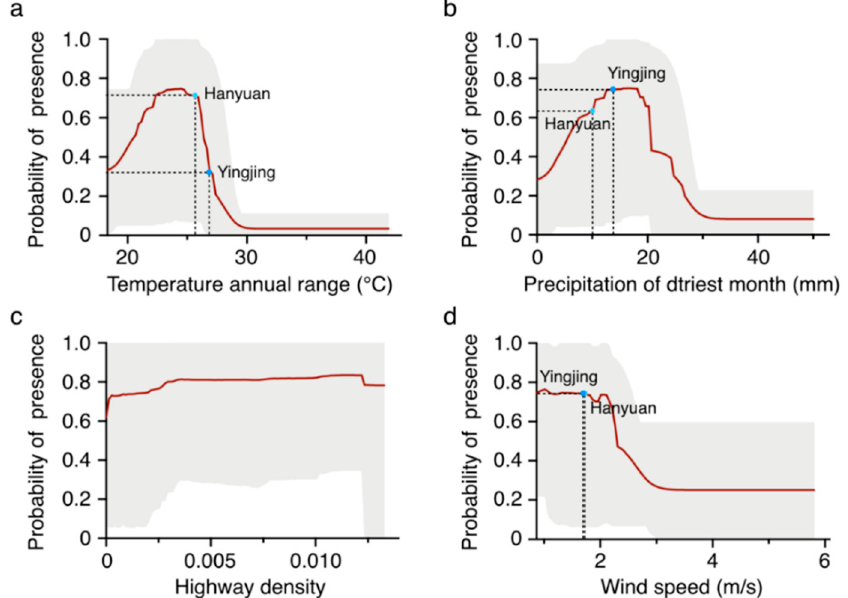
Figure 3. Response curves of key variables influencing A. adenophora distribution. The average values of all four variables in Hanyuan and Yingjing are marked. ( a ) Response curve of temperature annual range (°C). ( b ) Response curve of precipitation of driest month (mm). ( c ) Response curve of highway density. ( d ) Response curve of precipitation of wind speed (m/s).